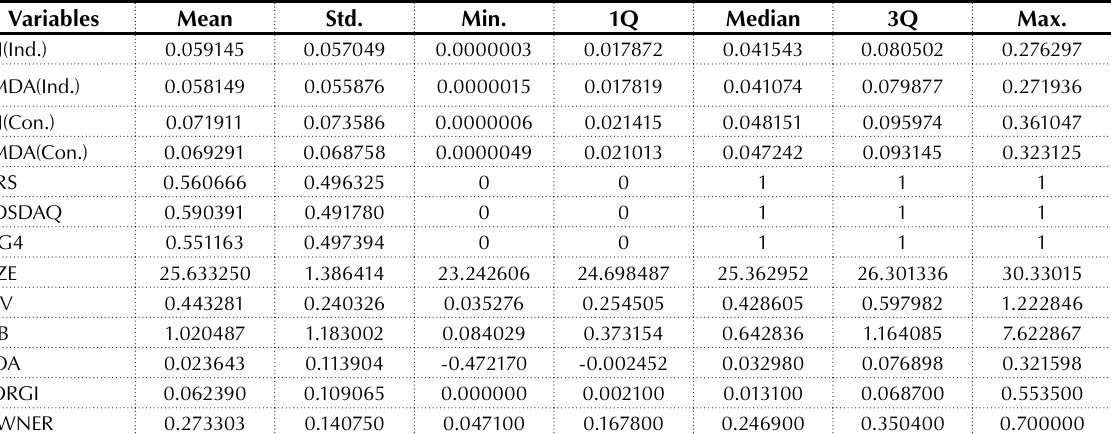
Table 1. Descriptive statistics (n = 13,154)